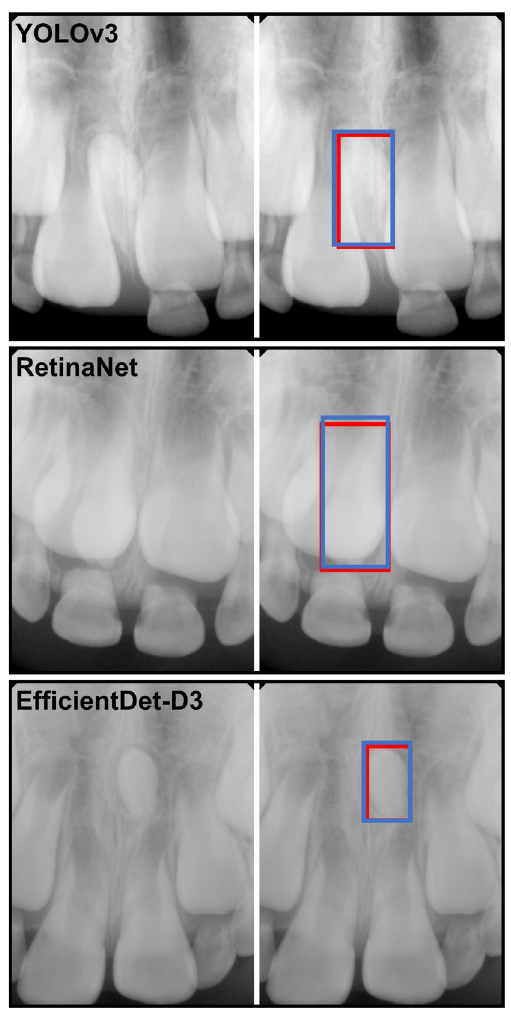
Figure 7. Examples of correctly detected mesiodens in the YOLOv3, RetinaNet, and EfficientDet-D3 models. The left side of each case is the original periapical radiograph, and the right side is the result of each model. The manually annotated label by the radiologist is shown as the blue box and the automatically detected mesiodens is shown as the red